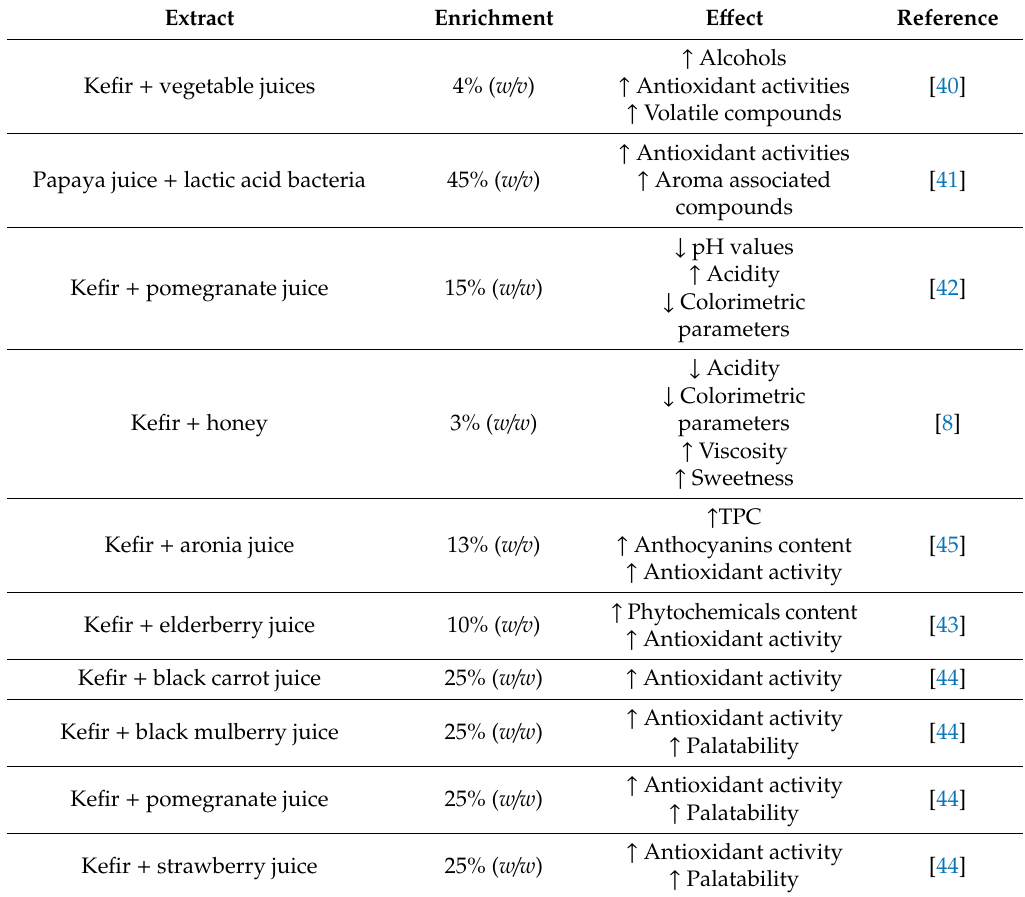
Table 3. Kefir fortification with juices and